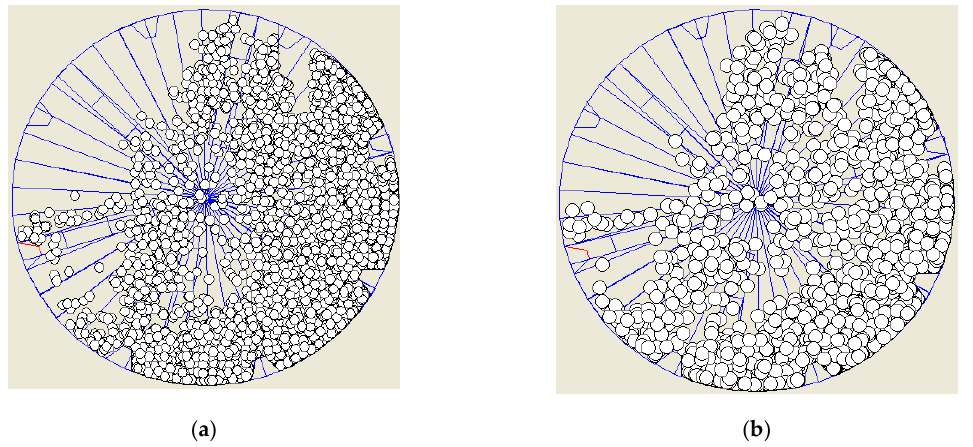
Figure 12. Snapshot of the balls of different sizes acting on the end liners. ( a ) 25 mm balls. Simulated power 2114 W. ( b ) 35 mm balls. Simulated power 1995 W.